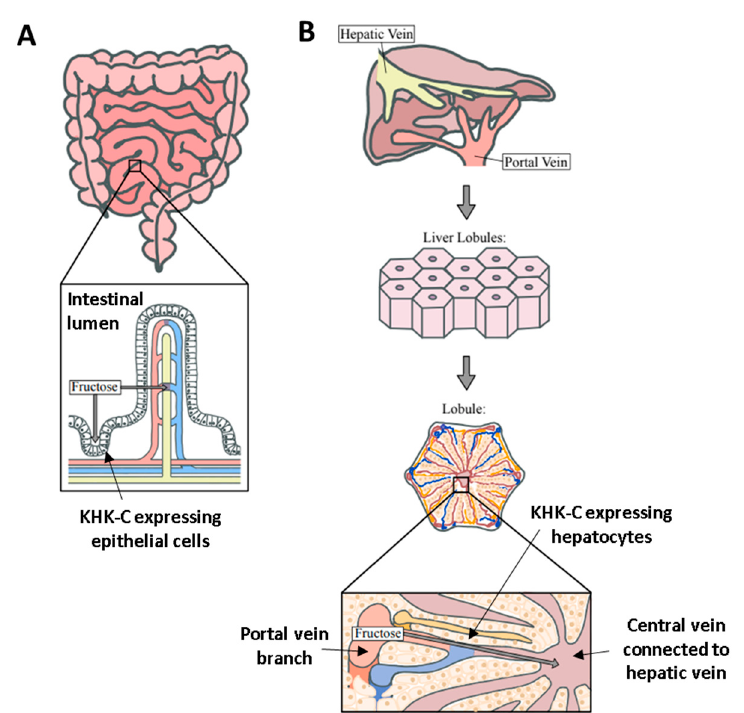
Figure 3. Anatomical difference between the liver and intestine for fructose catabolism. ( A ) In the intestine, there is a single-layer of KHK-C expressing epithelial cells between the intestinal lumen and blood vessel (fructose diffusion is perpendicular to the cell layer). This structure limits the fructose catabolic capacity when the delivered fructose dose is high. ( B ) In contrast, in the liver, there are numerous KHK-C-expressing hepatocytes lining the portal-to-hepatic circulation. Hepatocytes are also metabolically highly active to efficiently assimilate fructose carbons via gluconeogenesis and fat synthesis.